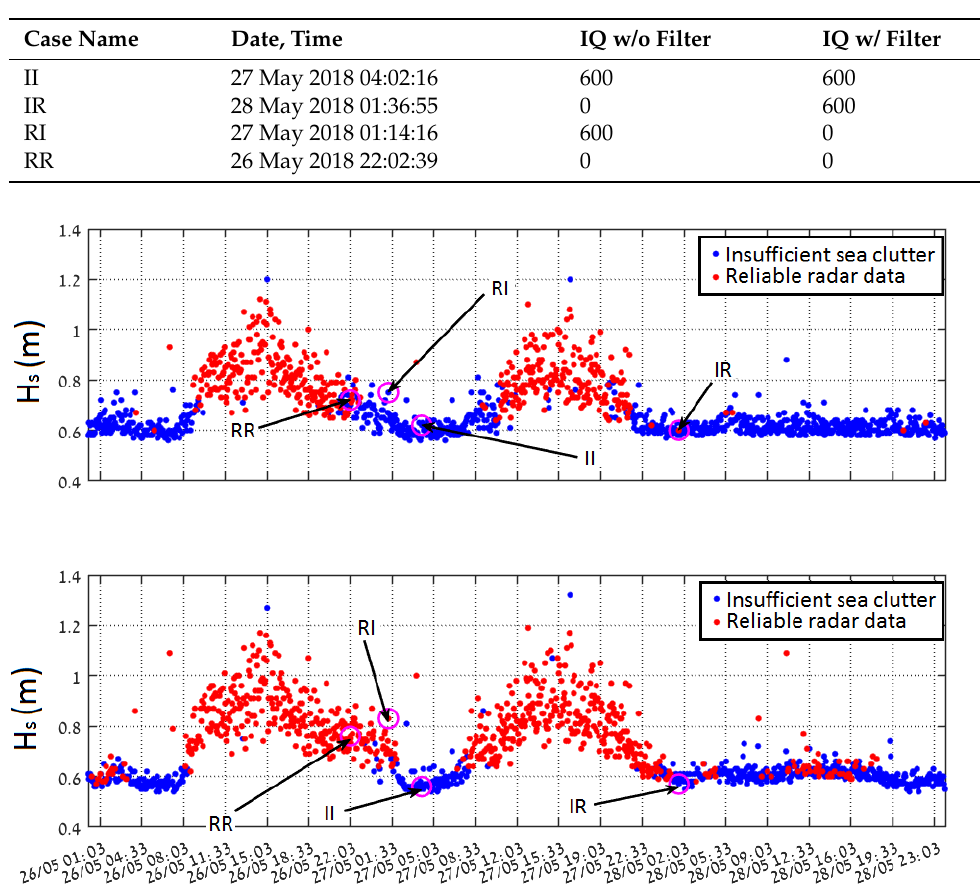
Table 2. Time stamps of the cases chosen by different quality control scores (IQ)